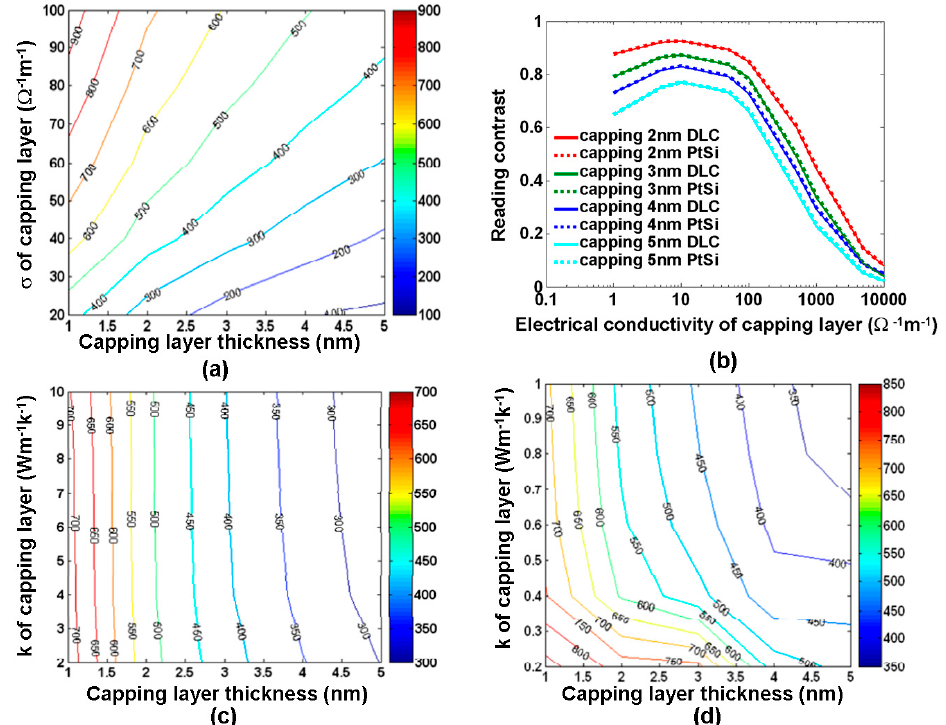
Figure 7. ( a ) maximum temperature ( ° C) inside the GST layer during crystallization as a function of the electrical conductivity and the thickness of the capping layer by a 8 V pulse of 100 ns. ( b ) reading contrast as a function of the electrical conductivity and the thickness of the capping layer for a single crystalline bit by a 1 V potential. ( c , d ) maximum temperature inside the GST layer during crystallization as a function of the thermal conductivity and the thickness of the capping layer by a 8 V pulse of 100 ns. σ and k represent the electrical and thermal conductivities of capping layer respectively. Reproduced with permission from [26]. Copyright Ingenta Connect, 2015; [27].